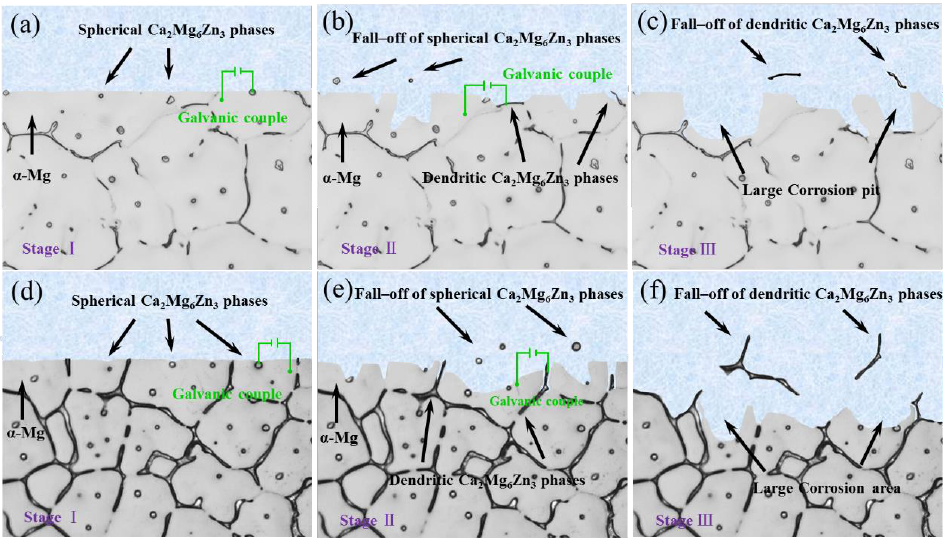
Figure 10. Schematic illustration of corrosion process of the investigated alloys in Hank’s solution: ( a – c ) ZM-0.1Ca alloy and ( d – f ) ZM-1.0Ca alloy.